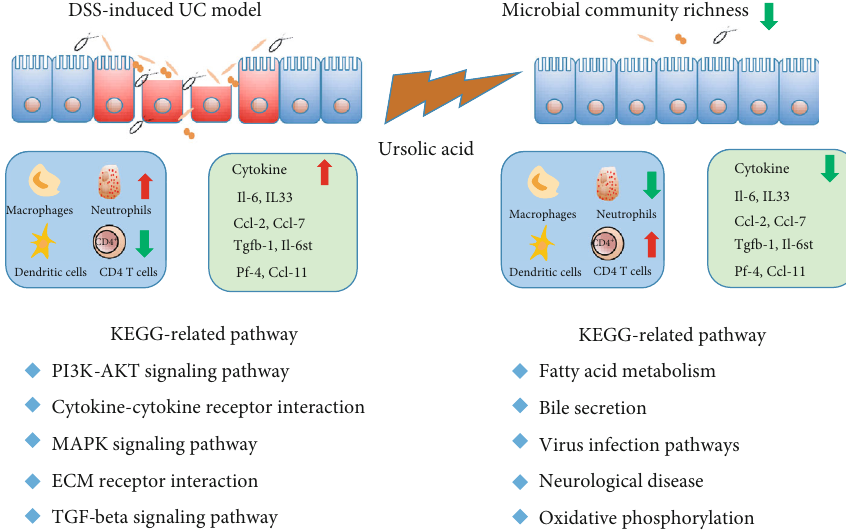
Figure 7: Schematic representation of UA function on the prevention and treatment of UC. DSS induced injury to the intestinal epithelial immune barrier, leading to the transfer of antigens into gut lamina propria. The red arrow means upregulation, and the green means